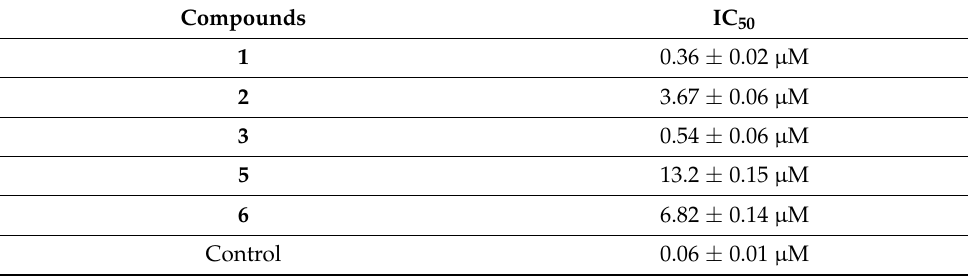
Table 4. IC 50 values of MAO-B